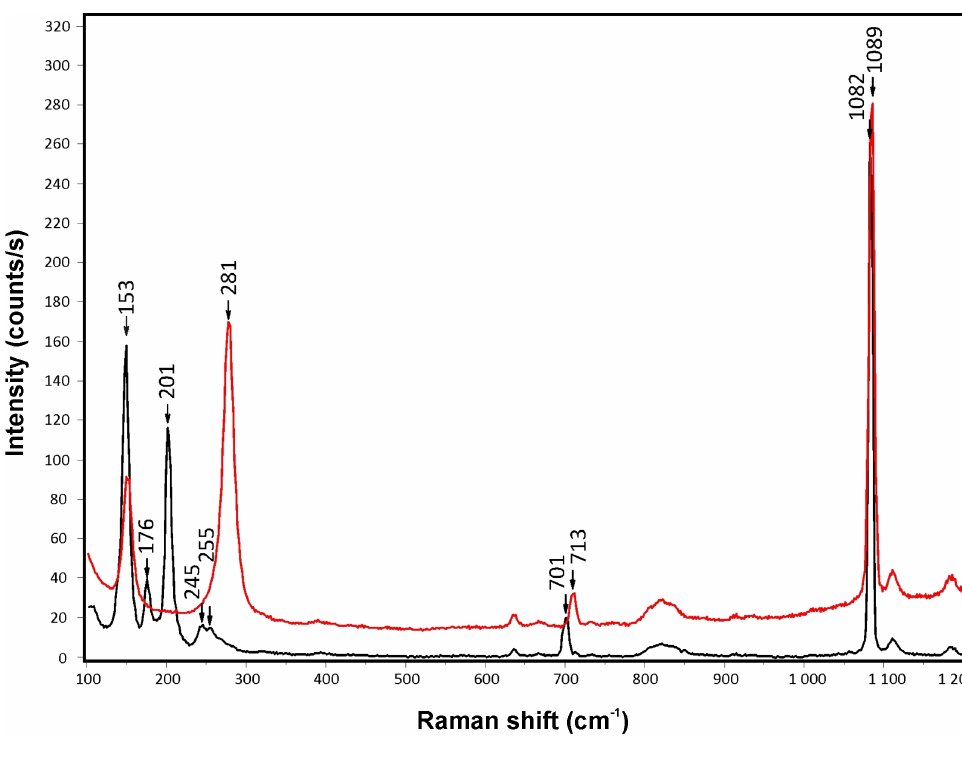
Figure 13. Uncorrected Raman spectra of aragonite crystal (black spectrum) and calcite groundmass (red spectrum) shown in Figure 12E. Spectra are offset for clarity. Not assigned bands are spectral artifacts from organic glue.